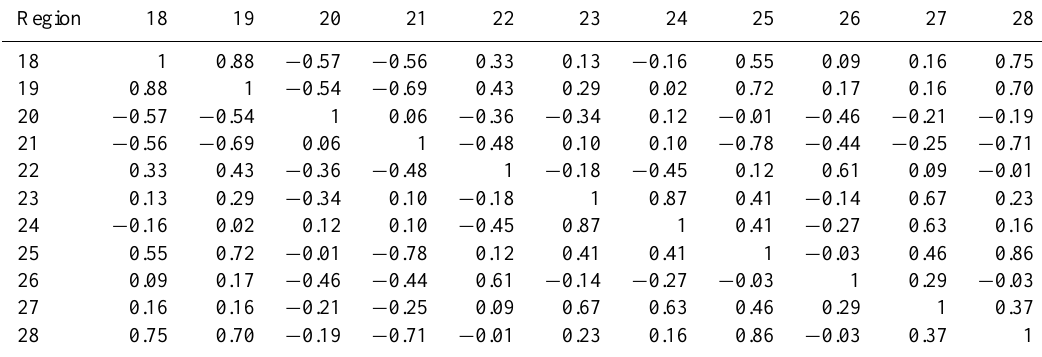
Table 5. Correlation coefficients of the change in the inverted flux from experiments 2a to that of experiment 2c among 11 regions in the US, calculated based on inverted annual fluxes in